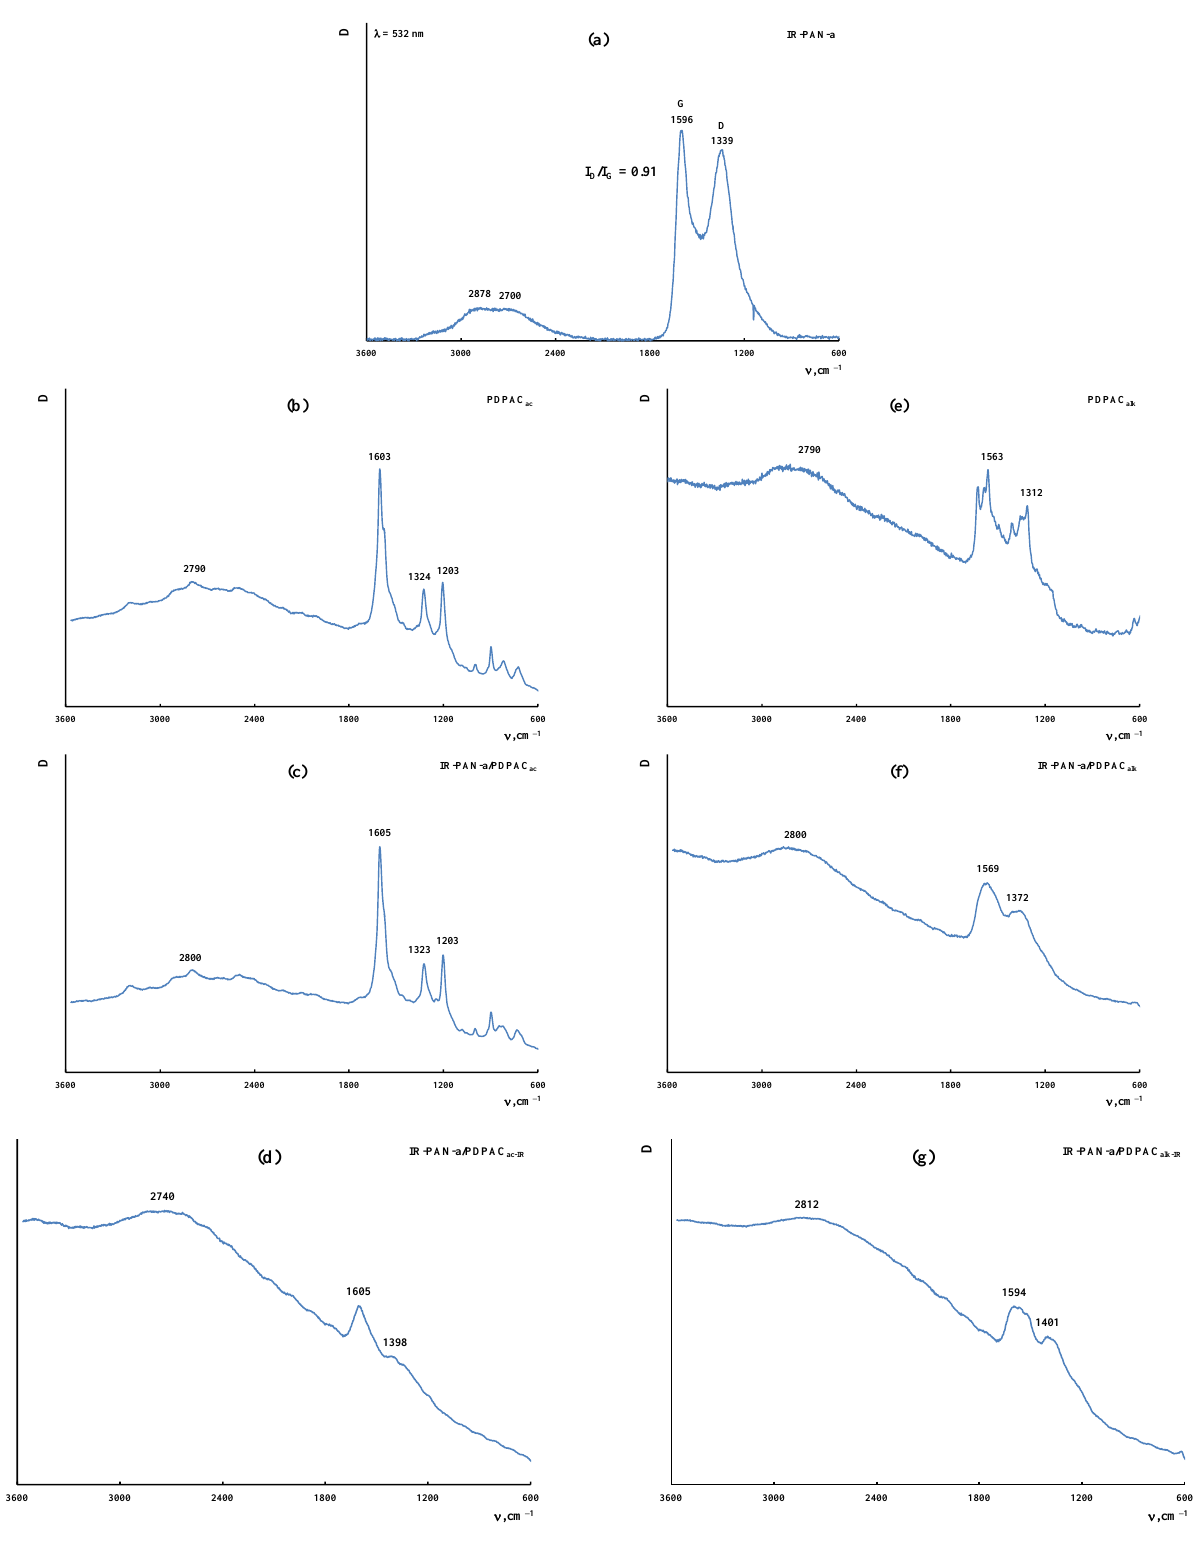
Figure 9. Raman spectra of IR-PAN-a ( a ), PDPAC ( b , e ), IR-PAN-a/PDPAC ( c , f ), and IR-PAN- a/PDPAC IR ( d , g ) prepared in an acidic ( b – d ) and an alkaline medium ( e – g ). Figures 10 and 11 show electron microscopic images of the IR-PAN-a/PDPAC composites. As can be seen, the morphology of the composites depends on the pH of the synthesis reaction medium. IR-PAN-a/PDPAC ac has a globular structure, whereas in IR- PAN-a/PDPAC alk , cavities are formed in places of chloroform drops (Figure 10). According to the FE-SEM data, during the synthesis of the composites, the spongy structure of IR-PAN-a is filled with a monomer solution followed by the formation of a polymer layer on the surface of the carbon material (Figure 11). Figure 10. SEM images of IR-PAN-a/PDPAC ac ( a ) and IR-PAN-a/PDPAC alk ( b ).